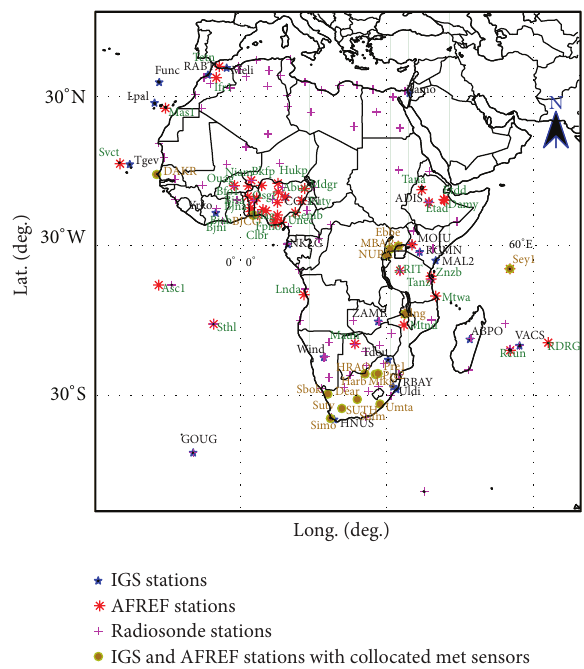
Figure 2: Map depicting the position of IGS and AFREF stations in